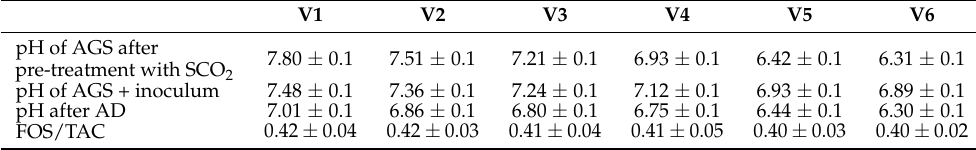
Table 3. Changes in pH values upon pre-treatment and AD and FOS/TAC after AD. V1 V2 V3 V4 V5 V6 pH of AGS after 7.80 ± 0.1 7.51 ± 0.1 7.21 ± 0.1 6.93 ± 0.1 6.42 ± 0.1 6.31 ± 0.1 pre-treatment with SCO 2 pH of AGS + inoculum 7.48 ± 0.1 7.36 ±